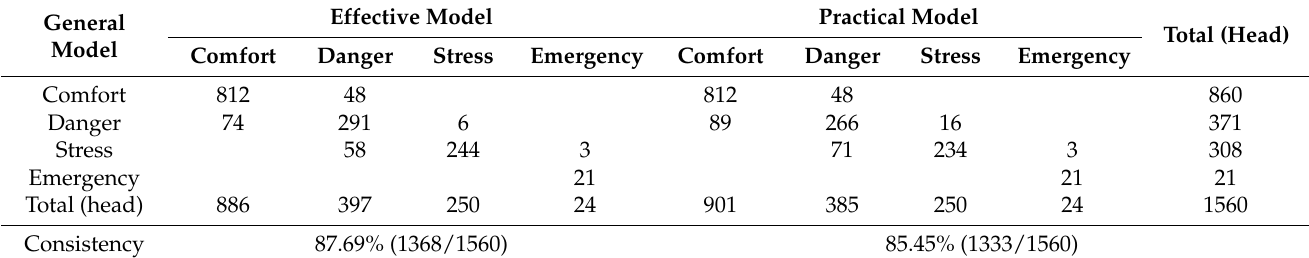
Table 6. Relationship among the classification of different environmental comfort indices.